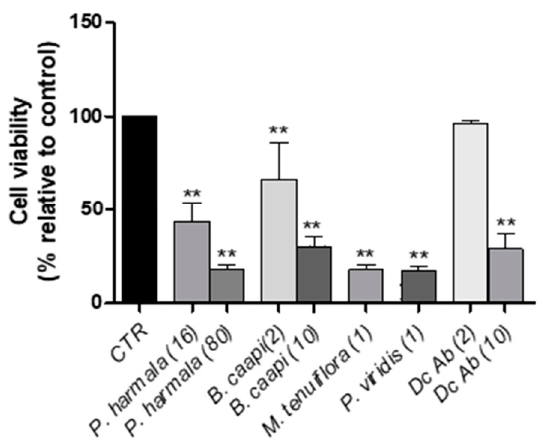
Figure 6. The e ff ects of P. harmala (16 and 80 µ M), B. caapi (2 and 10 µ M), M. tenuiflora (1 µ M), P. viridis Figure 6. The effects of P. harmala (16 and 80 µM), B. caapi (2 and 10 µM), M. tenuiflora (1 µM), P. (1 µ M) and Dc Ab (2 and 10 µ M) on N27 cell viability (24 h); CTR—control, ( n = 3, values are shown as viridis (1 µM) and Dc Ab (2 and 10 µM) on N27 cell viability (24 h); CTR—control, ( n = 3, values are mean ± SEM ** indicates values that are significantly di ff erent from control p < 0.01, one-way analysis shown as mean ± SEM ** indicates values that are significantly different from control p < 0.01, one- of variance followed by Dunnett’s multiple comparison way analysis of variance followed by Dunnett’s multiple comparison test).